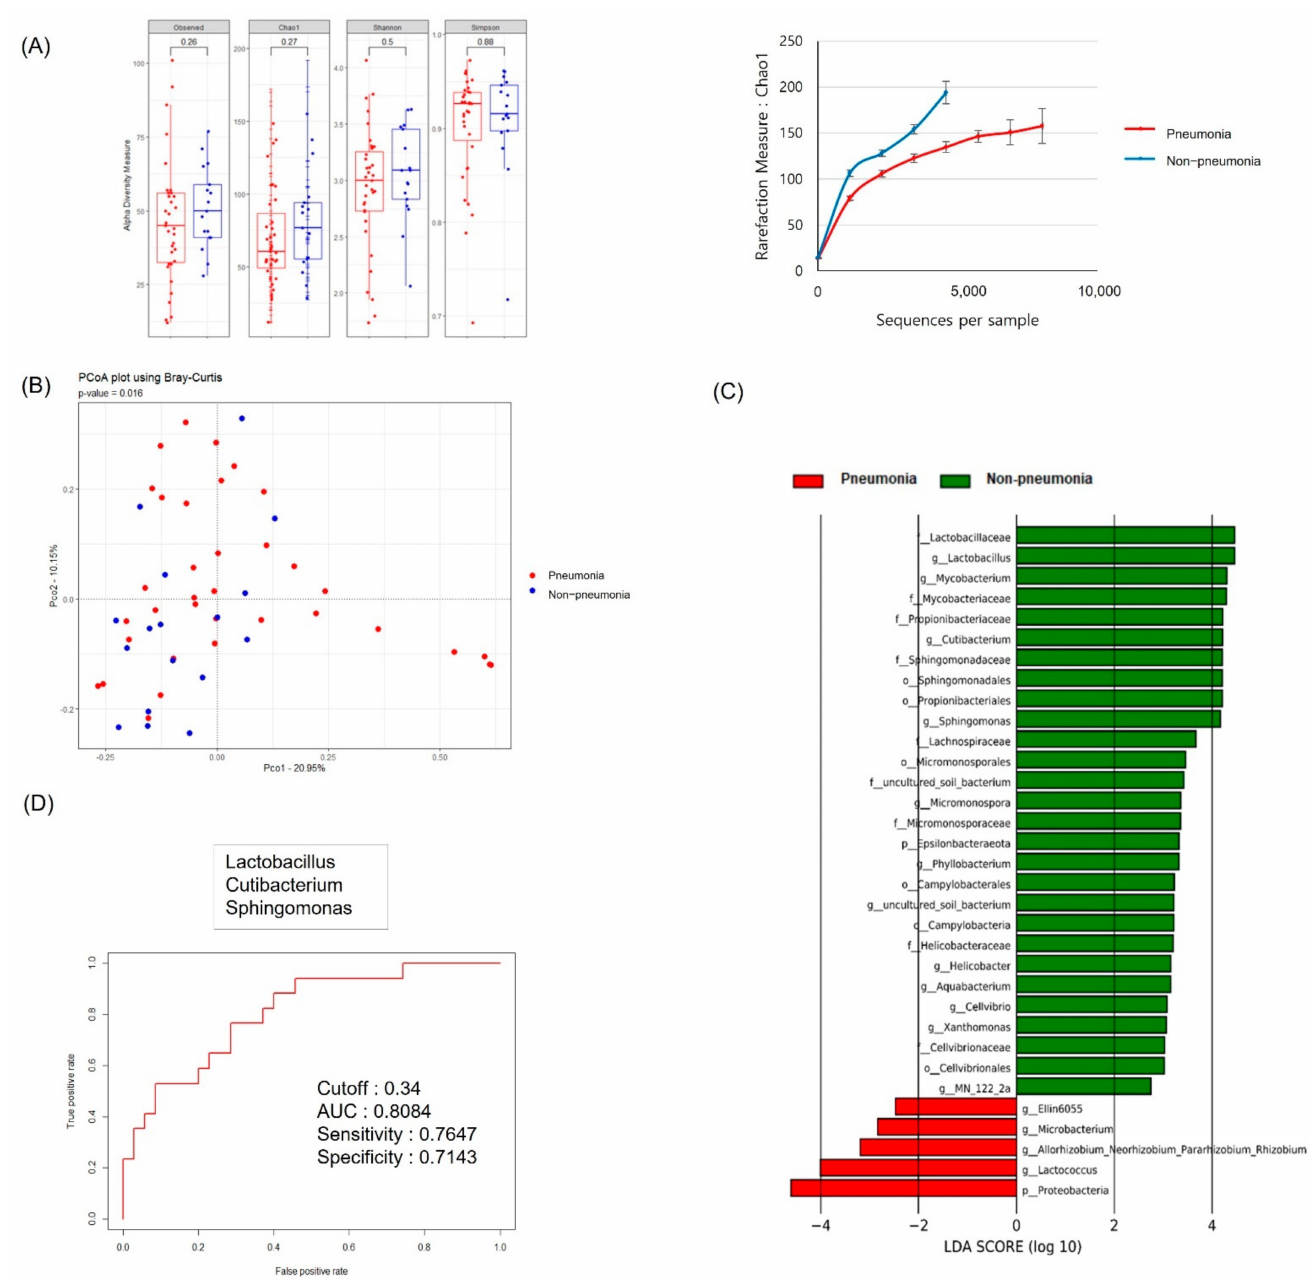
Figure 1. MEVs in the plasma of patients in the pneumonia and non-pneumonia groups. ( A ) α di- versity measures and rarefaction curves based on the Chao1 index of species richness. ( B ) PCoA of plasma MEVs at the genus level. ( C ) LEfSe − based plasma MEV biomarkers. ( D ) ROC curves showing the accuracy of MEV strain to discriminate between pneumonia and non-pneumonia. AUC 0.81 (95% CI 0.59–0.85), p = 0.233. EV: extracellular vesicle; LEfSe: linear discriminant analysis effect size; ROC: receiver operating characteristic; AUC: area under the receiver operating characteristic curve; CI confidence interval; f: family; o: order; p: phylum; c: class; g: